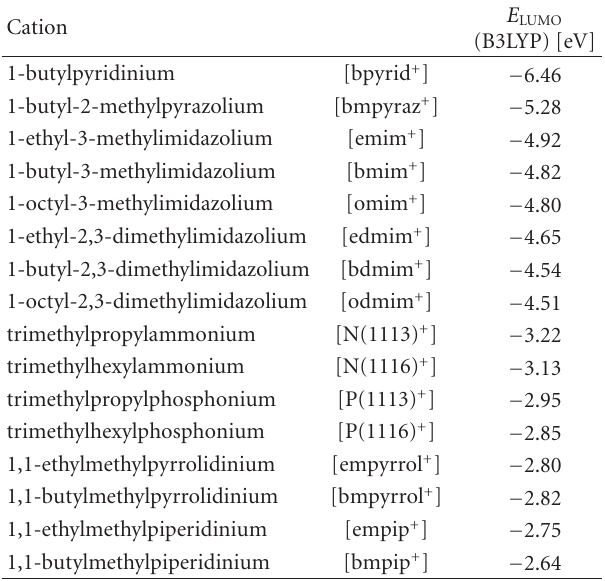
Table 2: Calculated LUMO energies (B3LYP) for several